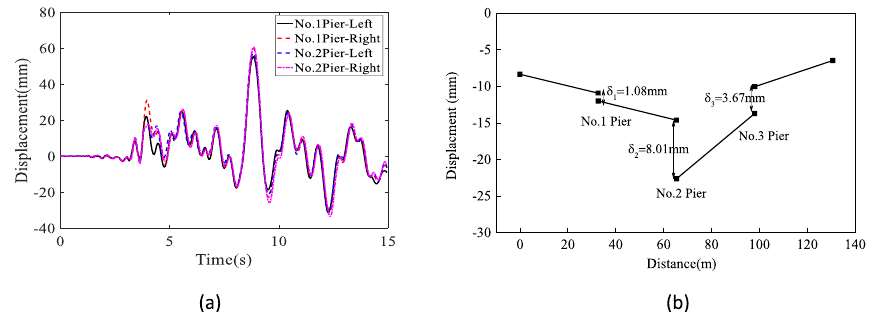
Fig. 3 Misalignment at girder end: a displacement response; and b misalignment